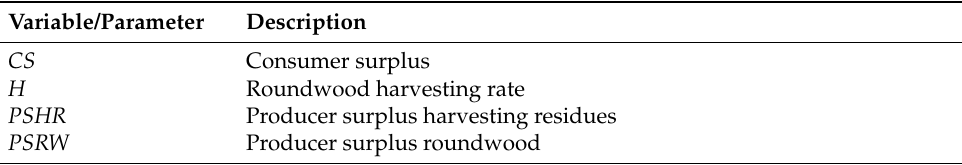
Table A3. Variable and parameter